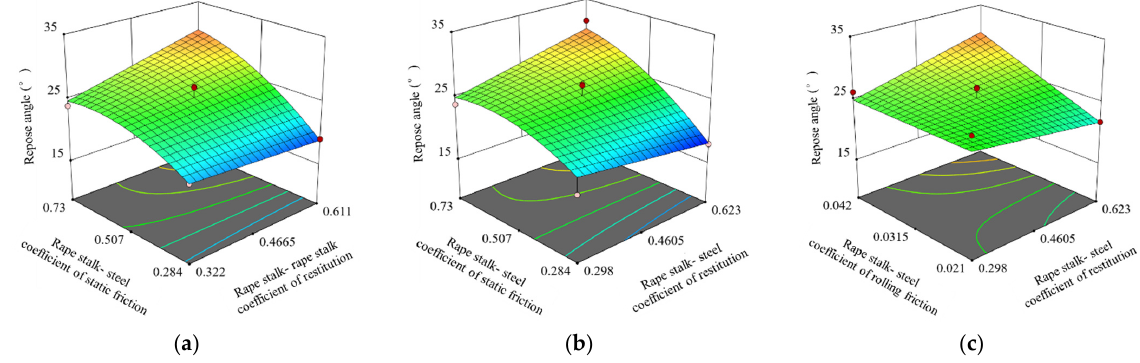
Figure 11. The effect of interaction factors on repose angle: ( a ) y 1 = f ( A 0.4605, E , 0.0315); ( b ) y 1 = f (0.4665, D , E , 0.507); ( c ) y 1 = f (0.4665, D , 0.0315, F ). Using the physical test measurement of the stacking angle of 27.15° as the optimization target, the combination of the contact parameters’ optimization model is: